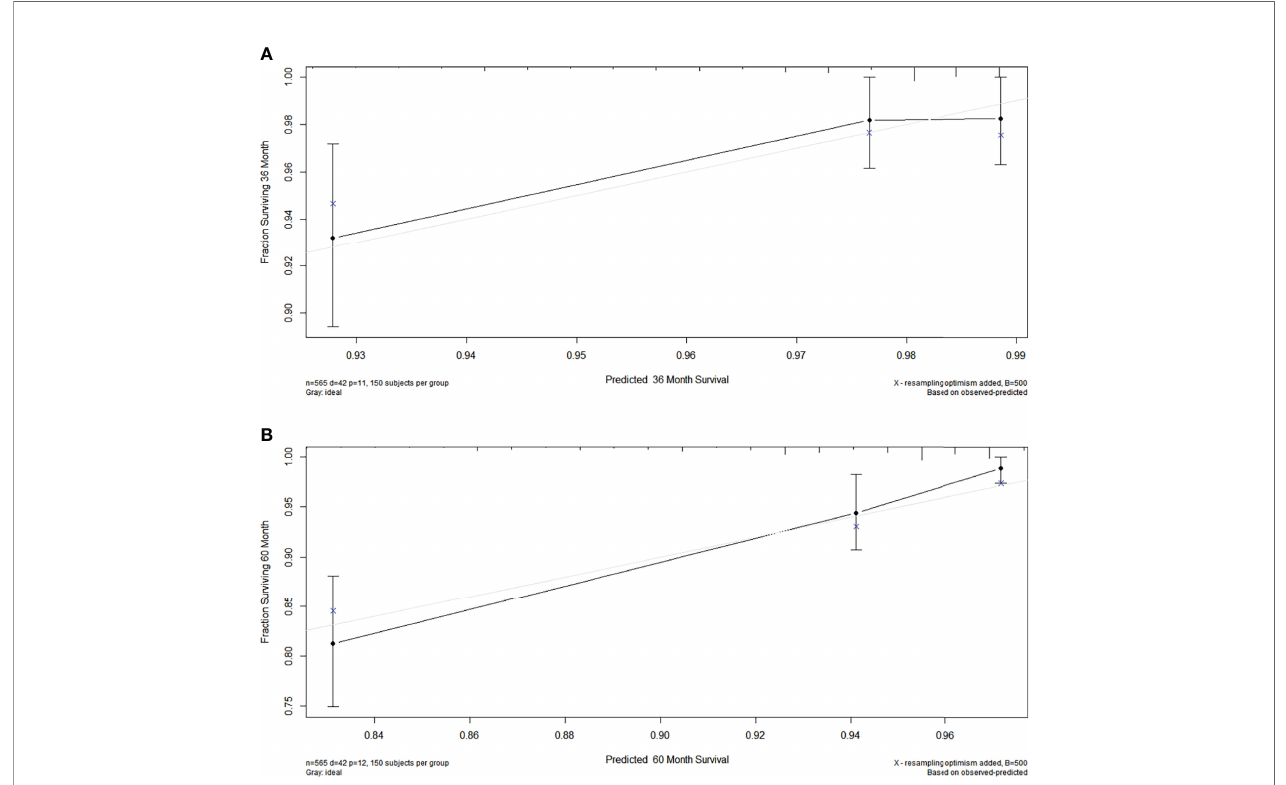
FIGURE 5 | The calibration plot established for the nomogram among patients of stage I EOC. The x-axis describes nomogram-predicted survival; the y-axis indicates observation survival. The graph along the 45° line shows the ideal calibration model, where the predicted probability is consistent with the actual result. (A) 3- year, (B) 5-